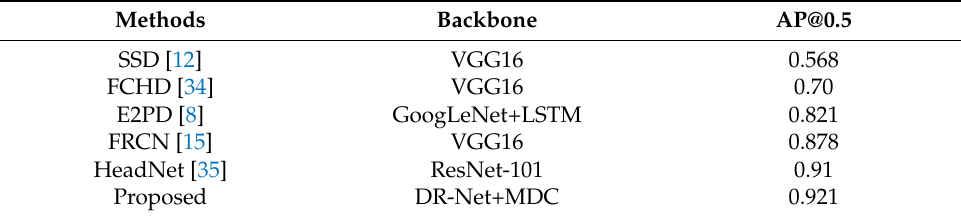
Table 6. Results of our method compared with other methods on the Brainwash